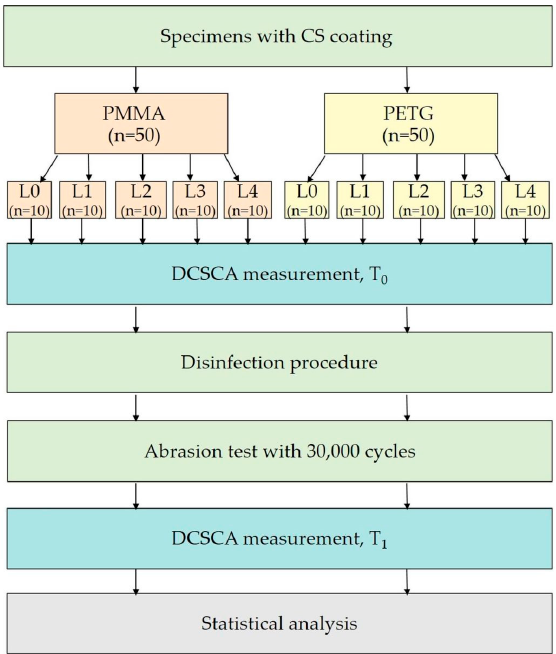
Figure 5. Study design. Baseline measurement (T 0 ) of damaged chitosan coating area (DCSCA), measurement after disinfection/abrasion test (T 1